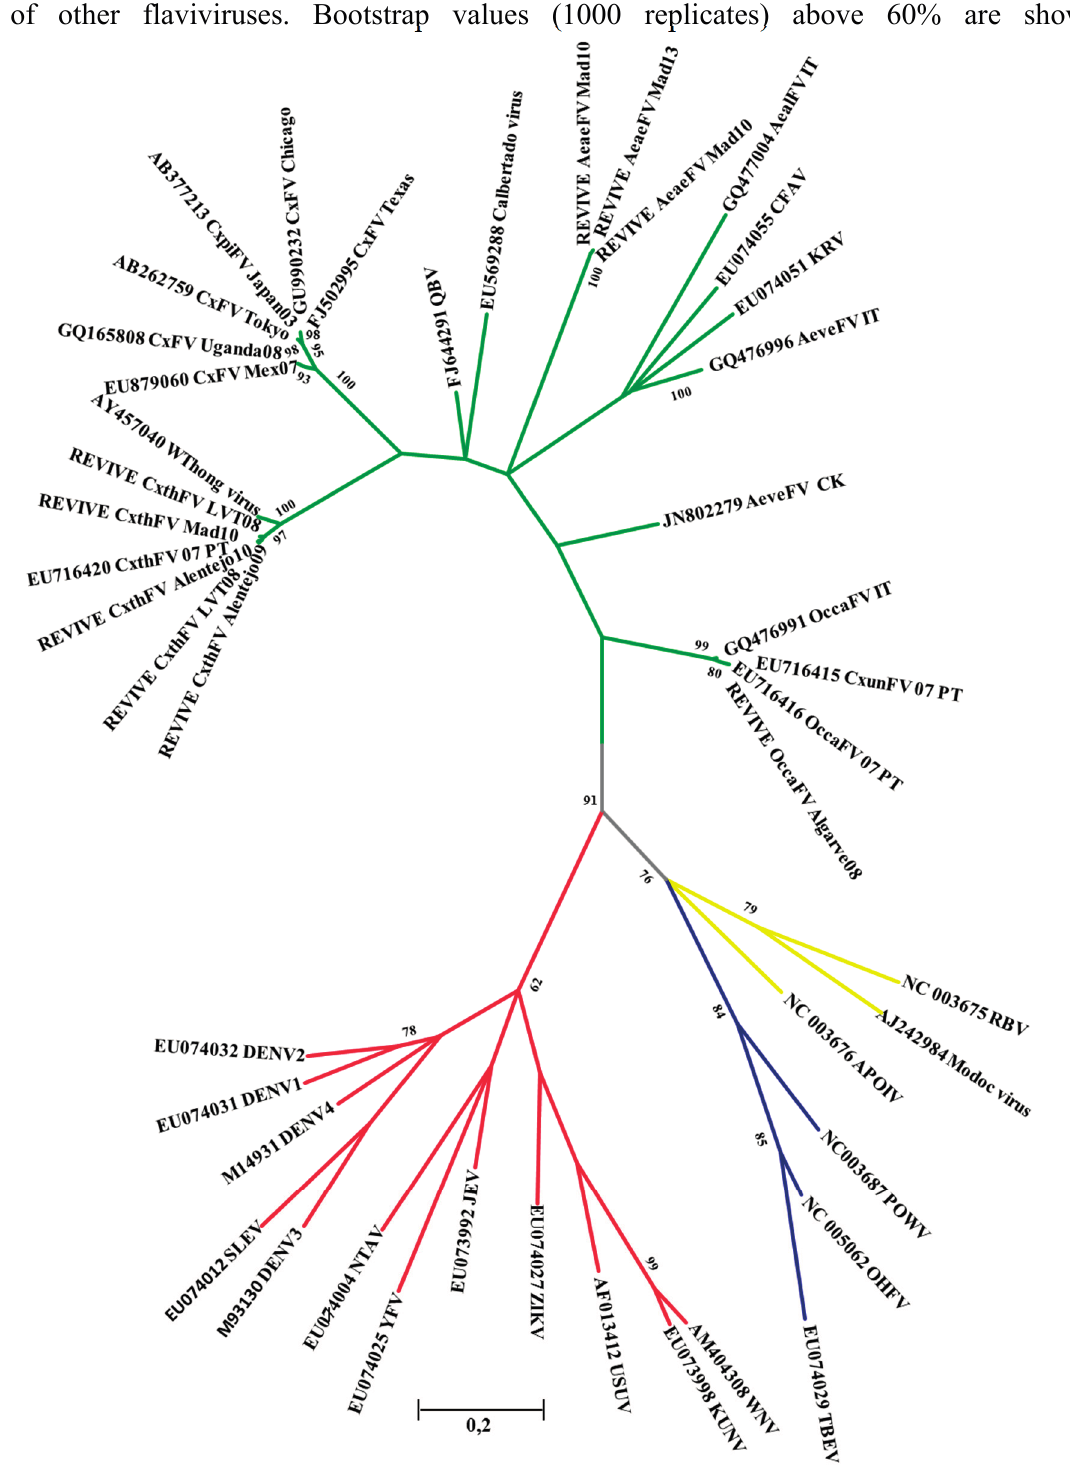
Figure 2. Maximum-likelihood tree obtained from NS5 partial sequences using Kimura two-parameter model of ISFs sequences detected under REVIVE and GenBank sequences of other flaviviruses. Bootstrap values (1000 replicates) above 60% are